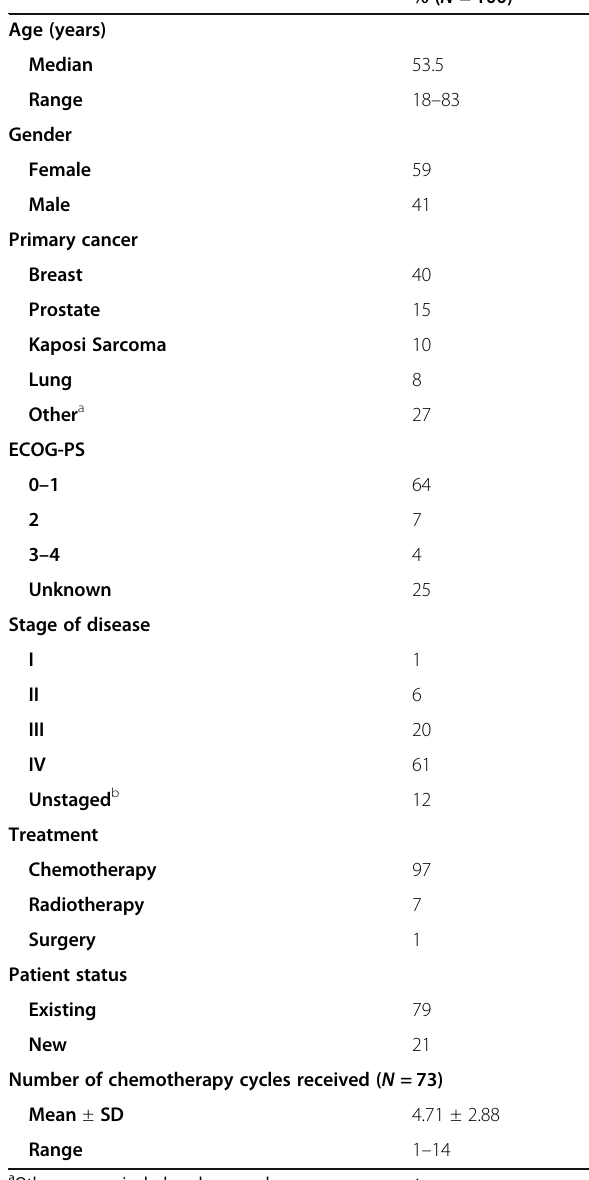
Table 1 Patient Demographics and Clinical